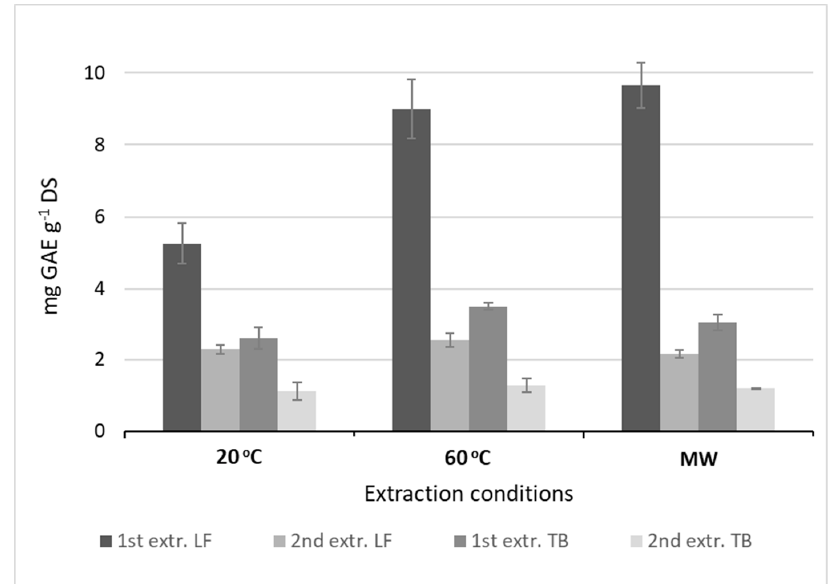
Figure 1. Effect of two-step extraction (1st, 2nd) and different extraction conditions on the yield of total phenolic content (TPC; mg gallic acid equivalents per g dry substance) from Jerusalem artichoke leaf (LF) and tuber (TB). Bars represent the mean (±SD) of replicate extractions ( n = 2). Significant differences were observed between the extraction steps, and the extraction methods 20 °C, 60 °C, and microwaving (MW) (F 1, 2 = 18.51, p < 0.05).